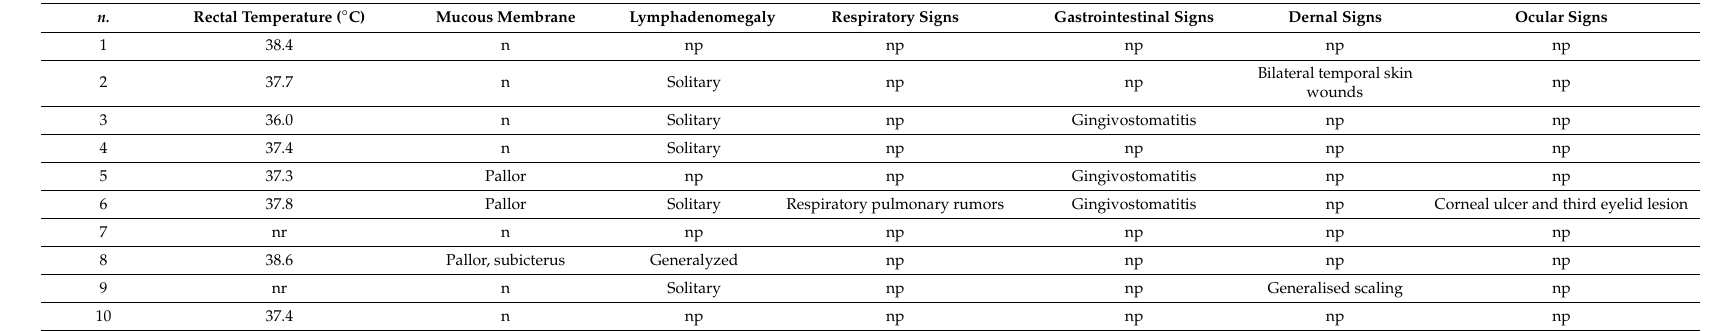
Table 4. Clinical data from ten Leishmania infantum infected stray cats from Northern Italy.